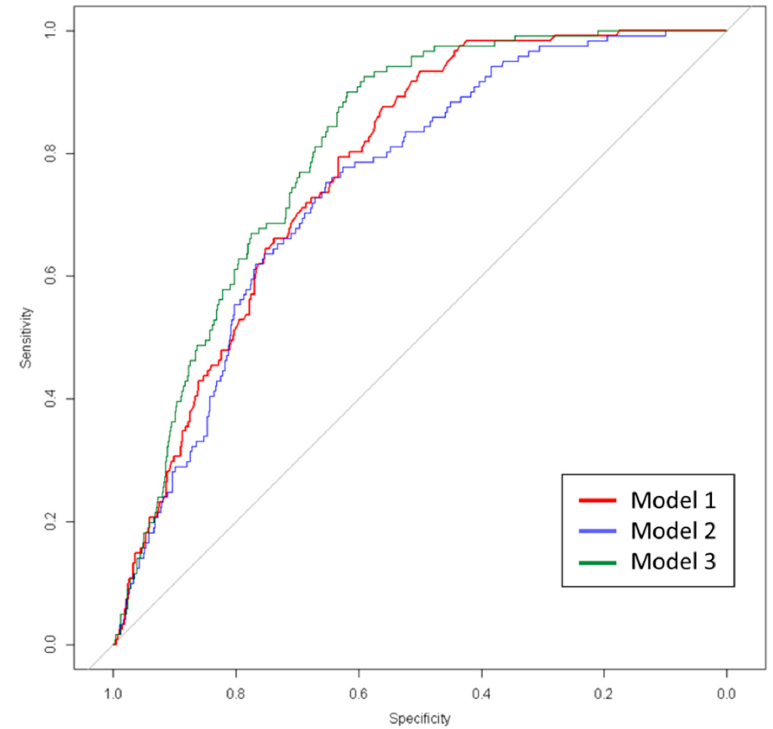
Figure 3. ROC curve of logistic regression for the three models.